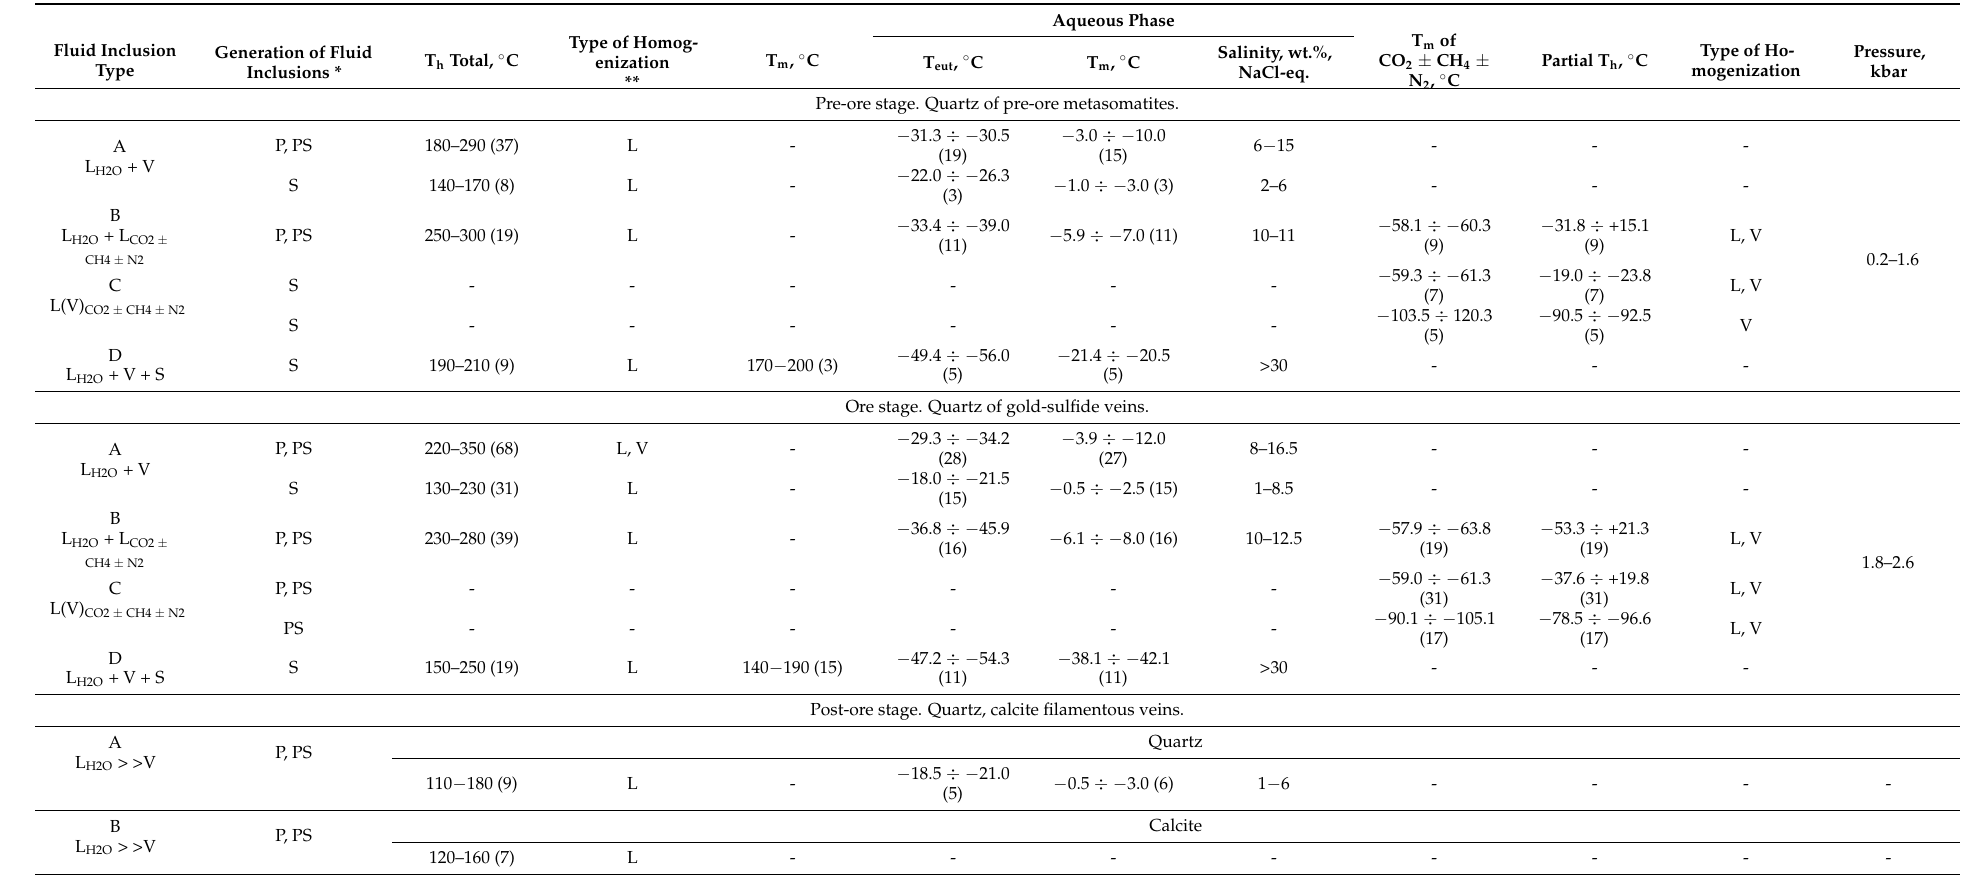
Table 1. Summary of fluid inclusion microthetrmetric data from the Blagodatnoye gold